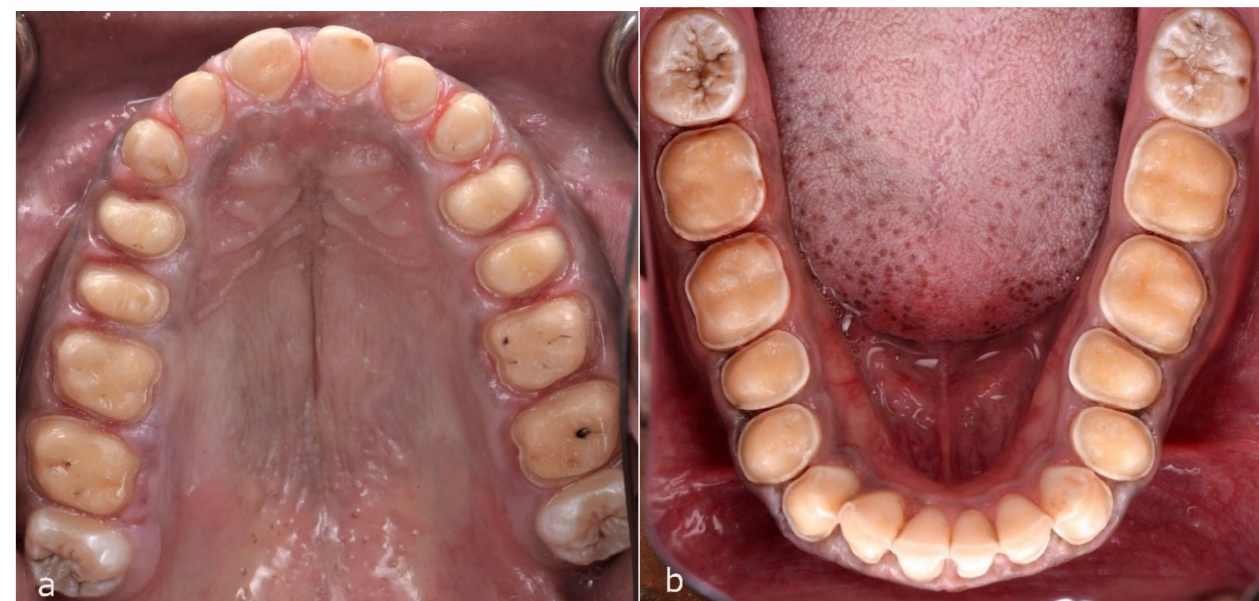
Figure 7. Final preparations: ( a ) maxillary abutment preparations and ( b ) mandibular abutment preparations.